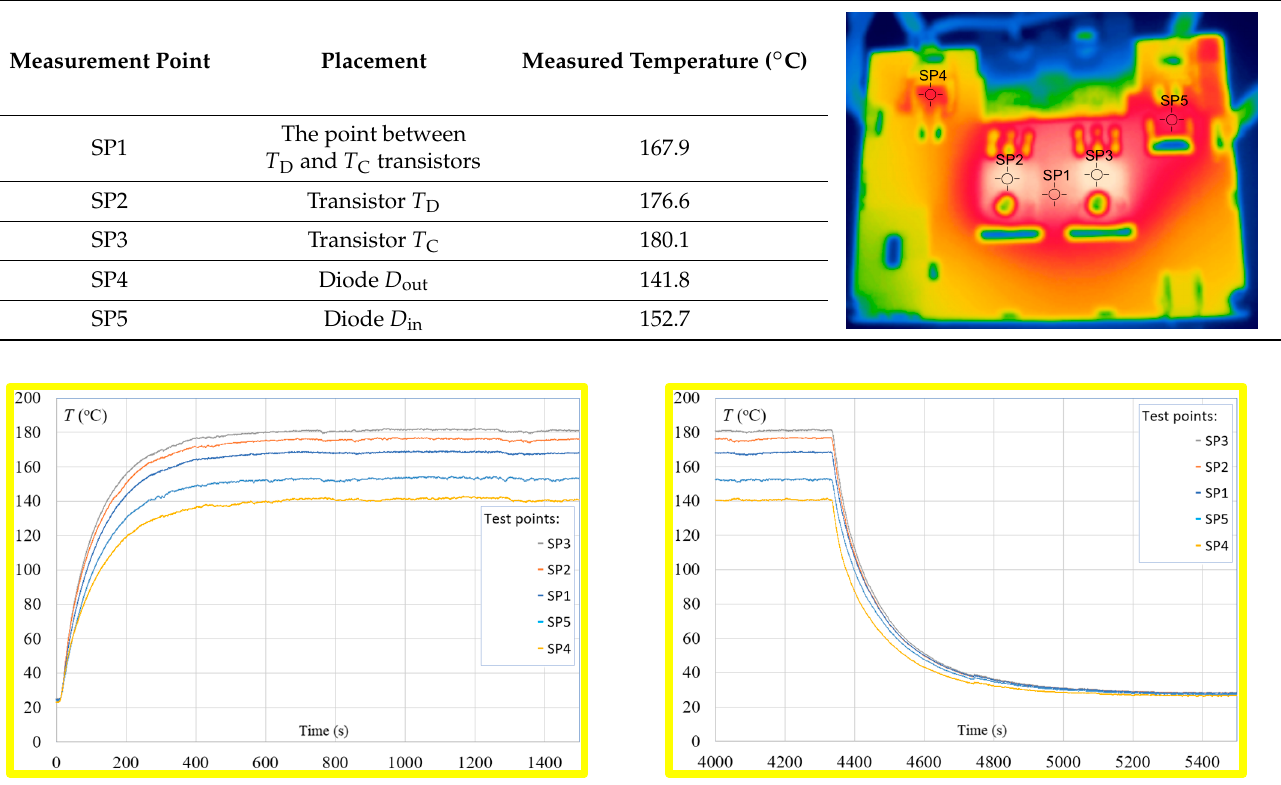
Table 3. The temperature of measurement points and results for P out = 700 W.